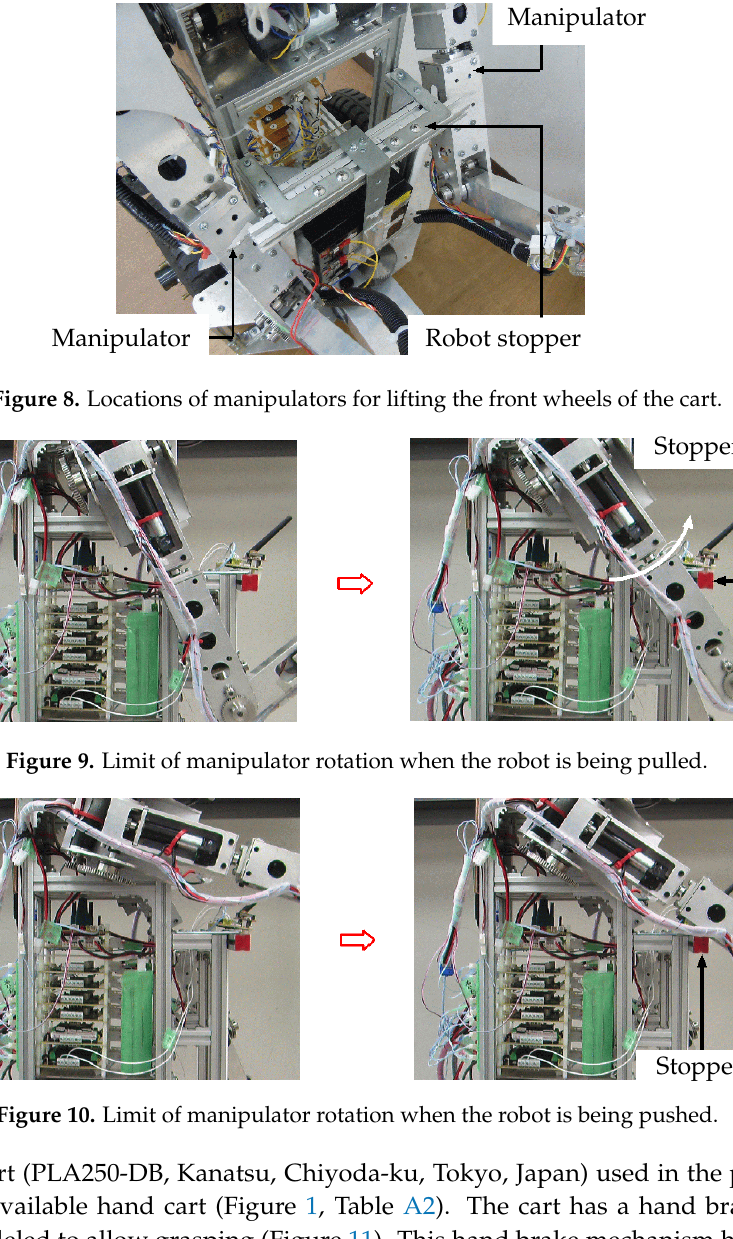
Figure 10. Limit of manipulator rotation when the robot is being pushed